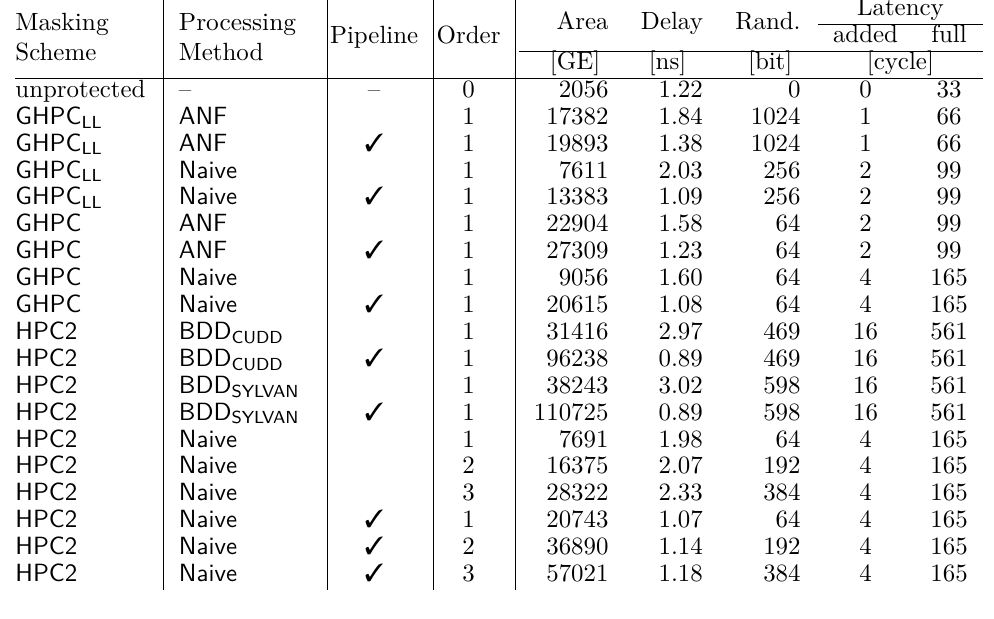
Table 13: Synthesis results, LED-64 round-based encryption